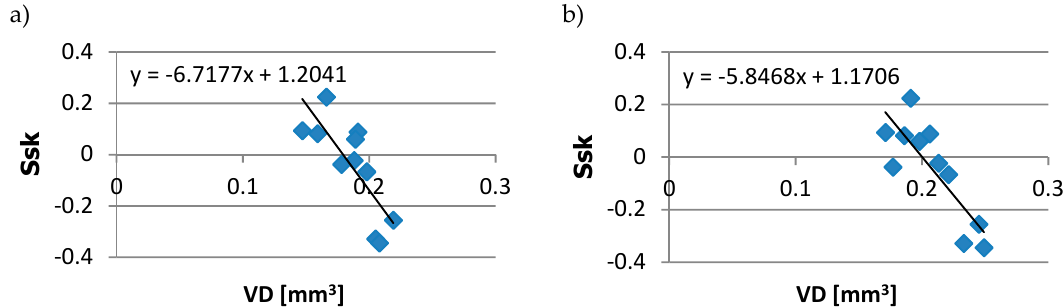
Figure 8. Dependency between disc volumetric wear VD and skewness Ssk at the sliding speed of: ( a ) 0.16 m/s; ( b ) 0.48 m/s.